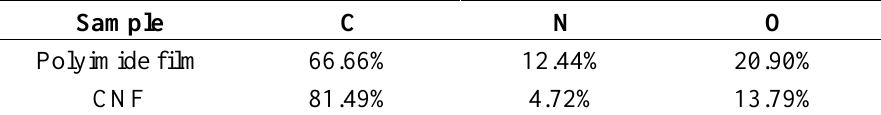
Table 1. Elemental composition of polyimide film and CNF.